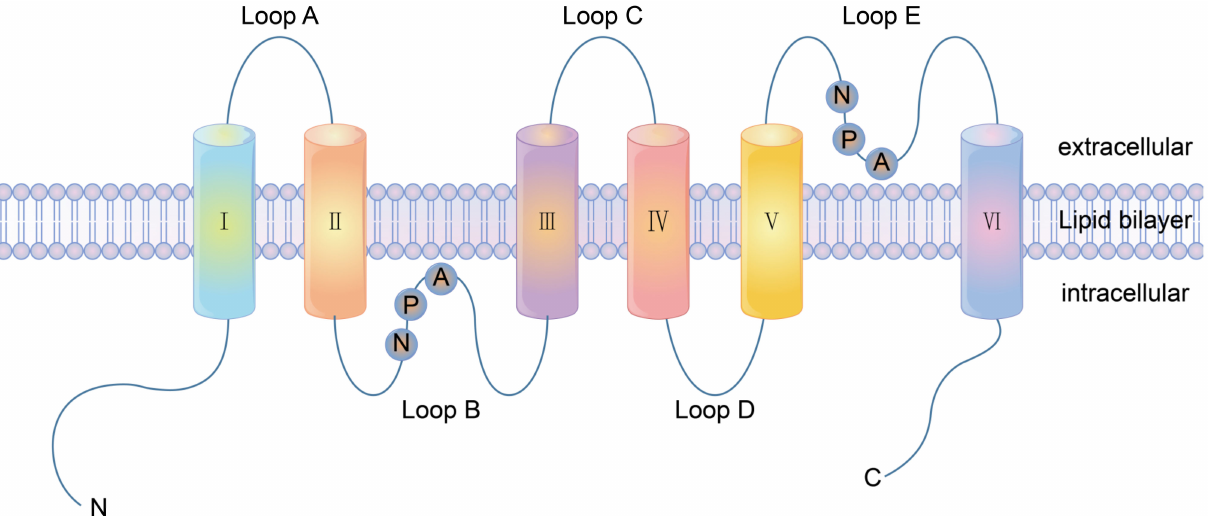
Figure 1. The structure of aquaporin AQP1 consisting of six transmembrane domains and five loops. A, C and E are located lateral to the plasma membrane, whilst B and D are located medial to the plasma membrane. Loop B and E are highly hydrophobic and have highly conserved ASN-pro-ALA (NPA repetitive tandem sequence), and are the passage regions of